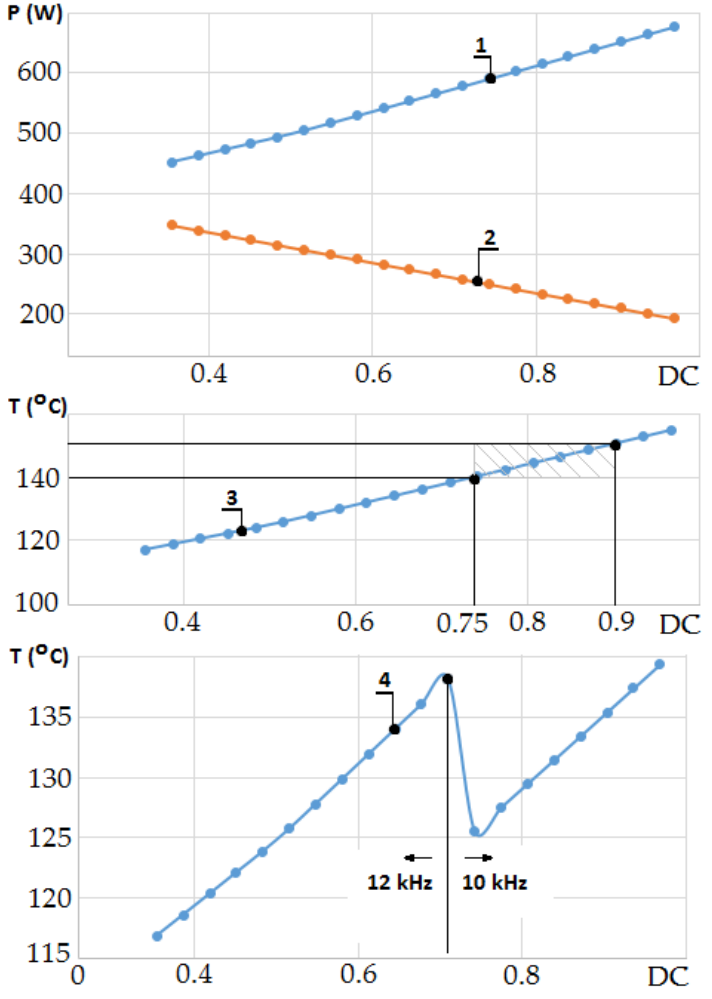
Figure 8. Buck mode of operation. 1–Buck transistor losses; 2–Buck diode losses; 3–Buck module temperature. 4–Reduction of the switching frequency from 12 kHz to 10 kHz.